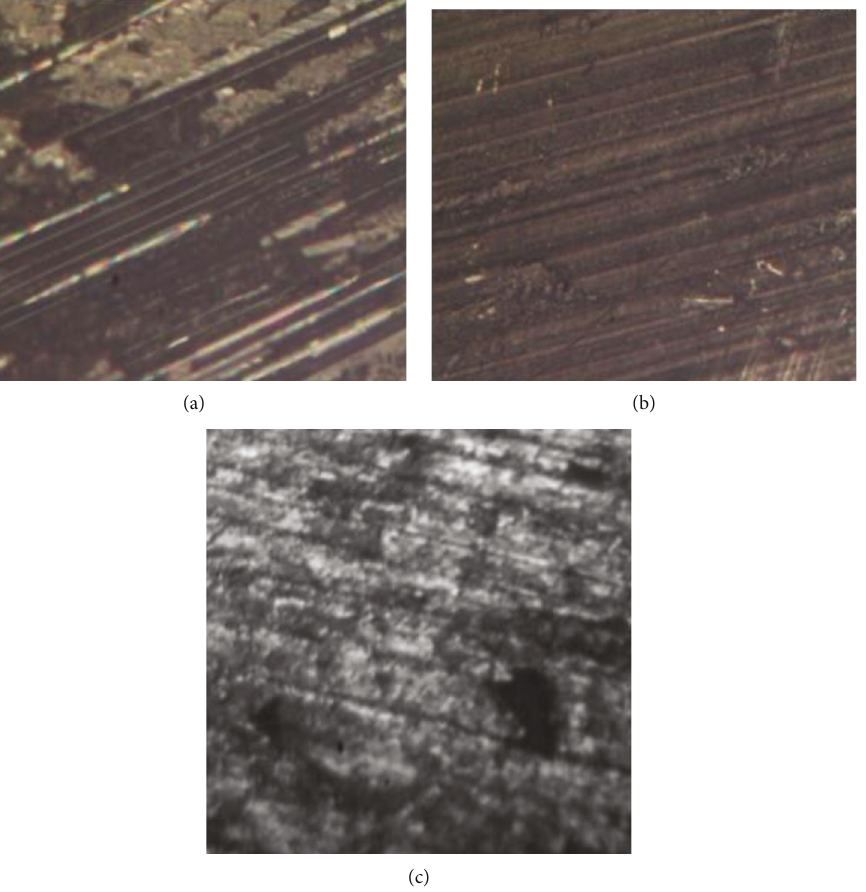
Figure 11: Optical micrograph of wear rate of the CSM glass and nanographite reinforced epoxy nanocomposites. (a) 0wt.%. (b) 1.5wt.%. (c) 2wt.%